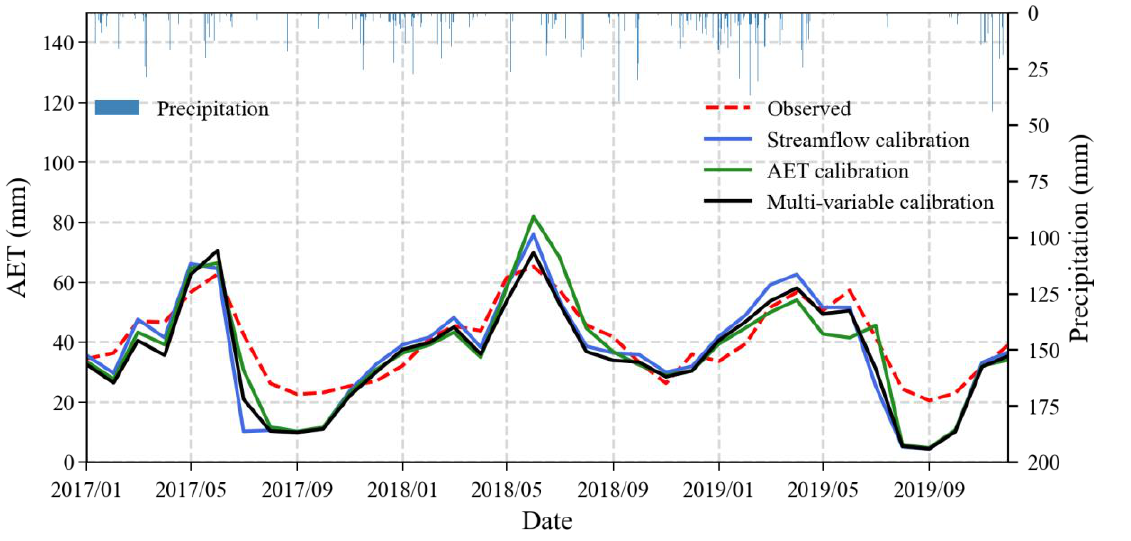
Figure 4. Simulated versus measured MODIS evapotranspiration for each calibration scenario at catchment scale.